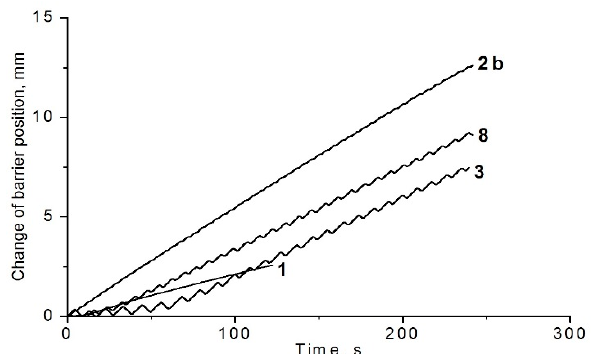
Figure 7. Barrier position vs. residence time of monolayers of 1 , 2b , 3 , and 8 at transfer pressure (compounds 1 and 2b , 15 mN/m; compound 3 , 20 mN/m; and compound 8 , 12 mN/m).